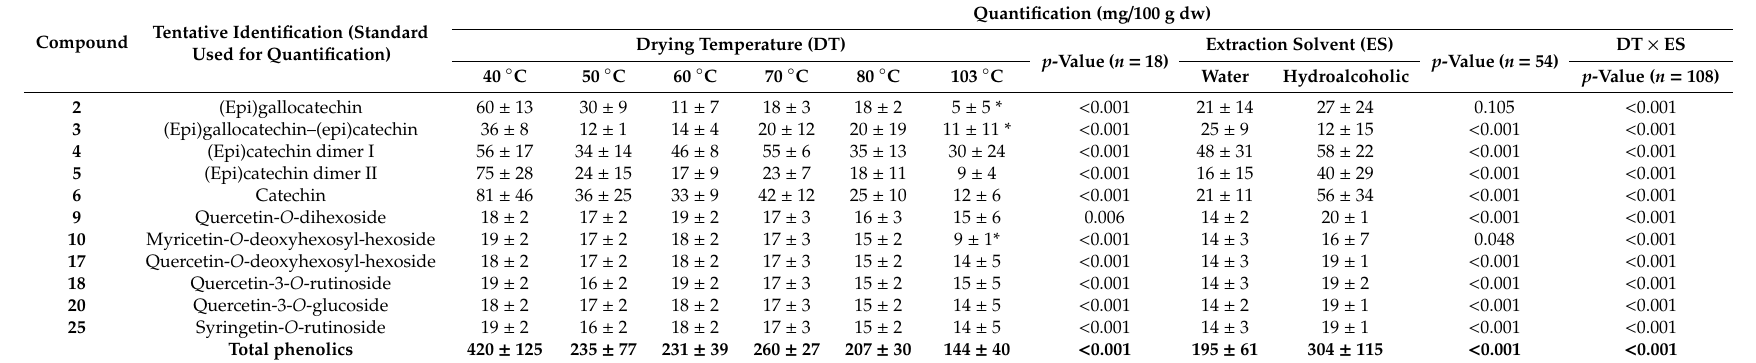
Table 3. Phenolic compound quantification in C. urucurana Baill. bark submitted to di ff erent drying and extraction